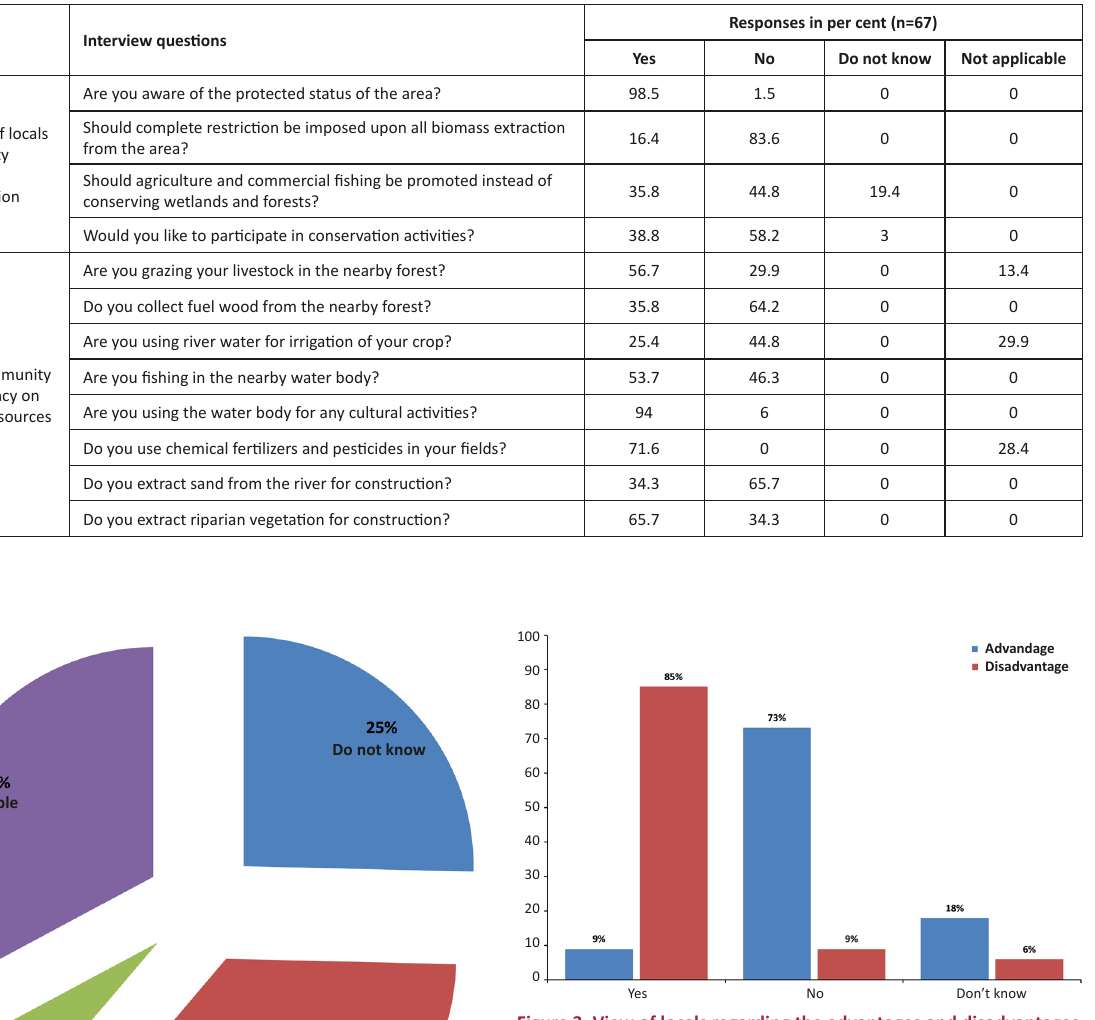
Figure 3. View of locals regarding the advantages and disadvantages of the sanctuary in the